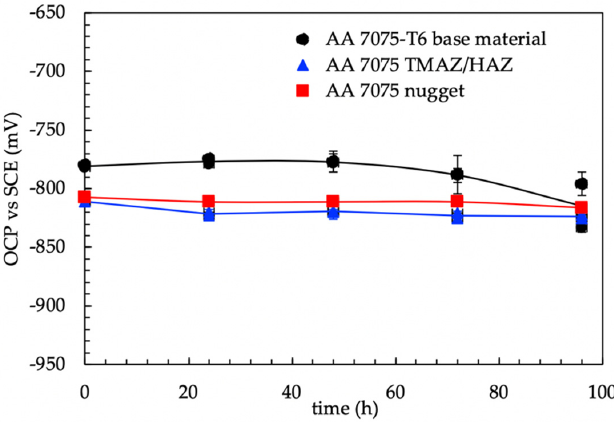
Figure 8. OCP vs time of the different zones (base materials, TMAZ and nugget) of the alloy AA7075 T6.